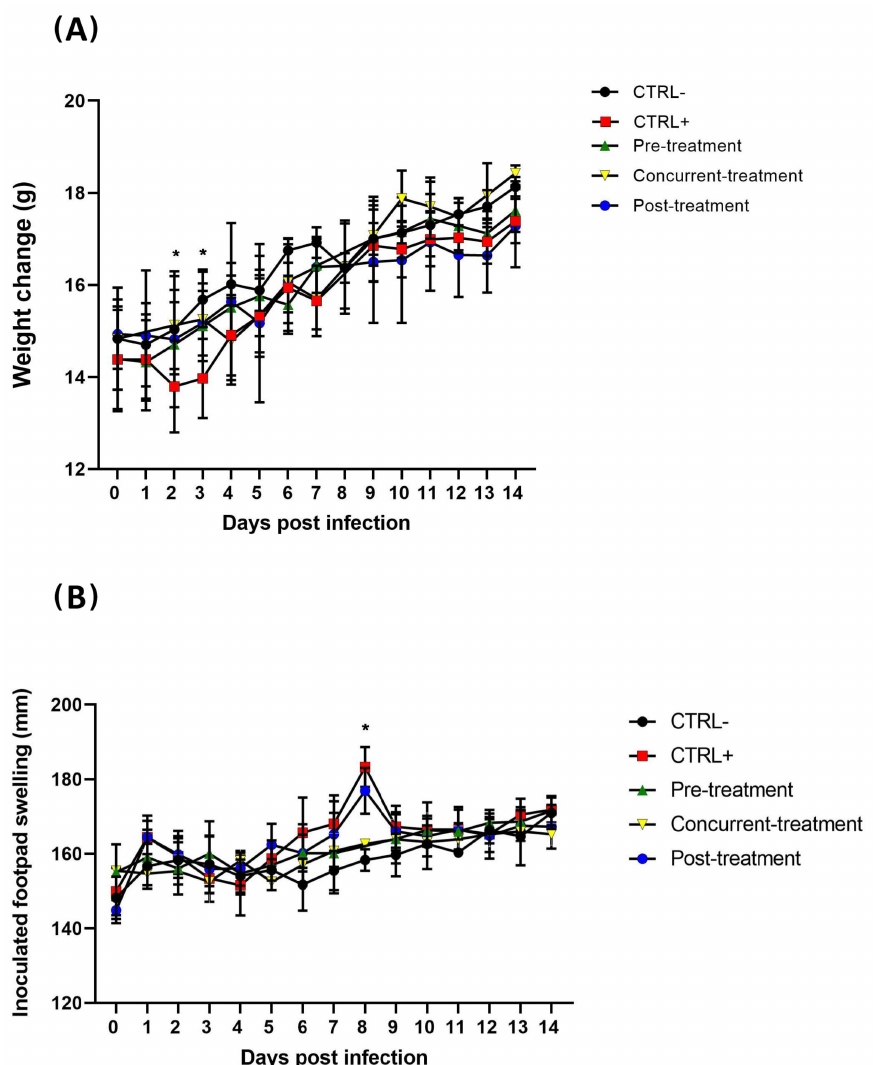
Figure 3. Favipiravir protected against body weight loss and footpad swelling in MAYV-infected mice. MAYV-infected mice (10 6 pfu) were either treated with Favipiravir at different times of infection or not treated at all. ( A ) Body weight and ( B ) footpad swelling. Numbers of mice were variable within groups as some were sacrificed at 7 dpi and the remaining at 14 dpi. * represents p < 0.05, two-way ANOVA was used for statistical analysis. Error bars indicate standard